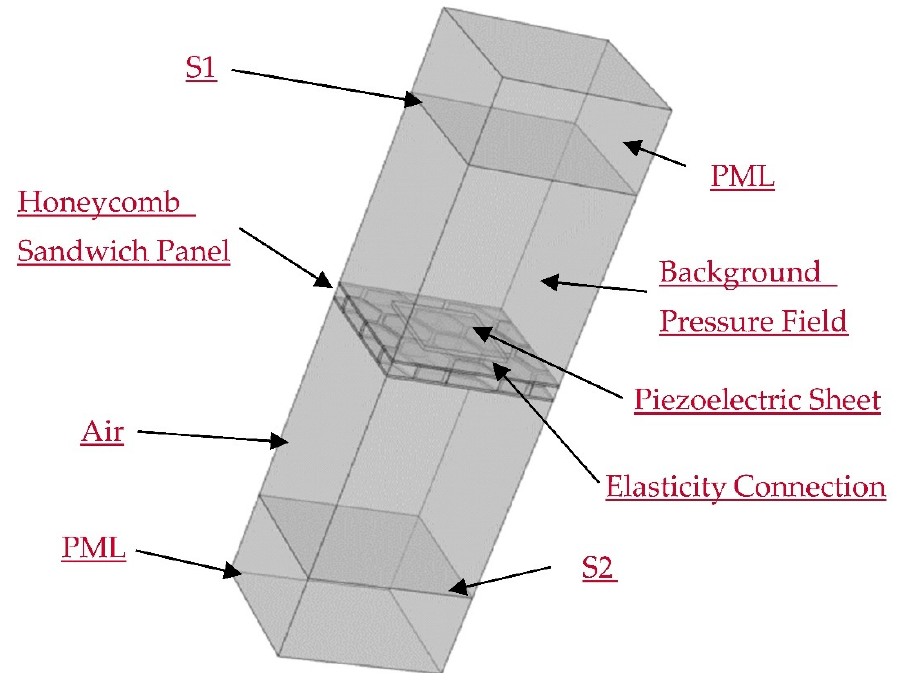
Figure 7. The schematic diagram of the finite element model.